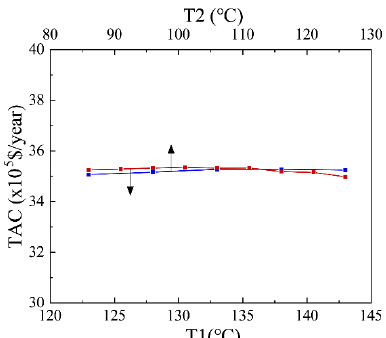
Figure 7. Effect of the temperature of the first and second condensers on the total annual cost of the heat integration process. As indicated by the arrow, the red line represents the variation of TAC with the temperature of the first condenser, while the blue line represents the variation of TAC with the temperature of the second condenser.